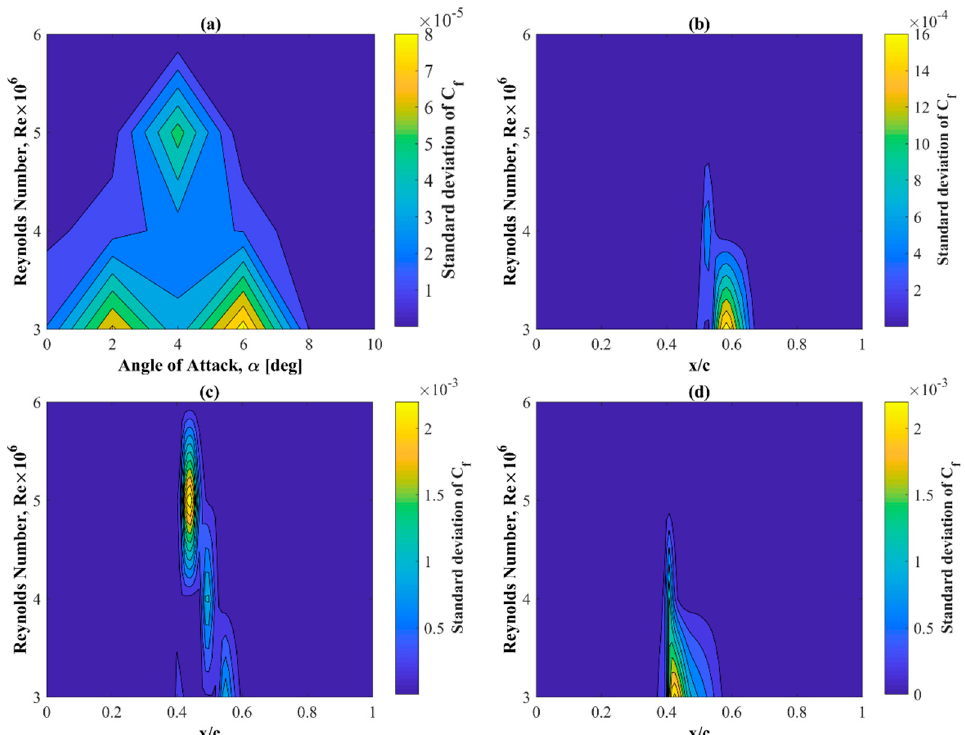
Figure 15. Standard deviation of the skin friction coefficient for the suction side of the airfoil—the effect of the angle of attack and the Reynolds number ( a ); the effect of the Reynolds number and x/c for: 𝛼 = 2° ( b ); 𝛼 = 4° ( c ); and 𝛼 = 6° ( d ).